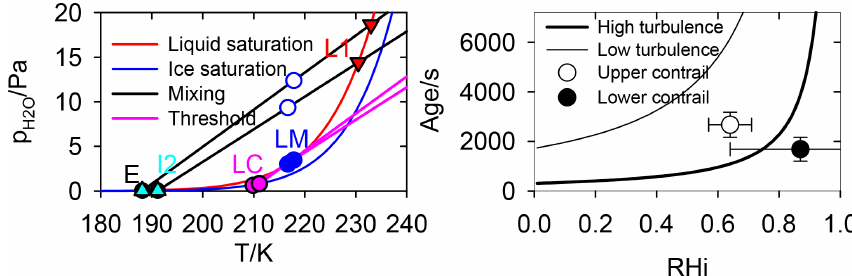
Figure 16. Left: Schmidt–Appleman criterion (SAC) for stratospheric conditions with saturation pressures for ice and liquid water (blue and red curves) and mixing lines (black, full for lower contrail, dashed for upper contrail) between exhaust and ambient conditions. Letters at symbols identify LM (maximum potential liquid saturation at saturation and on the mixing line), L1 (first liquid saturation or dew point), I2 (last ice saturation), and LC (liquid threshold conditions). With growing dilution without phase changes, the plume state would approach E from above along the mixing line. The conditions in the environment E are T E =− 85 ◦ C, p = 85hPa, and RHi = 0.87 for the lower contrail and T E =− 82 ◦ C, p = 71hPa, RHi = 0.64 for the upper contrail, η = 0.1. Right: contrail age computed for conditions at I2 for variable ambient relative humidity relative to ice saturation, RHi. The age is derived such that the dilution at I2 equals the dilution at this age from the assumed dilution law (“high turbulence”, Eq. 4). The thin curves show the result for a factor 0.25 reduced dilution (“low turbulence”). The symbols with error bars show observed values of RHi and ages for the upper and lower contrail in the photo of 16 November 2005. The dashed lines and the open symbol are for the upper contrail, and the solid lines and the full symbol are for the lower